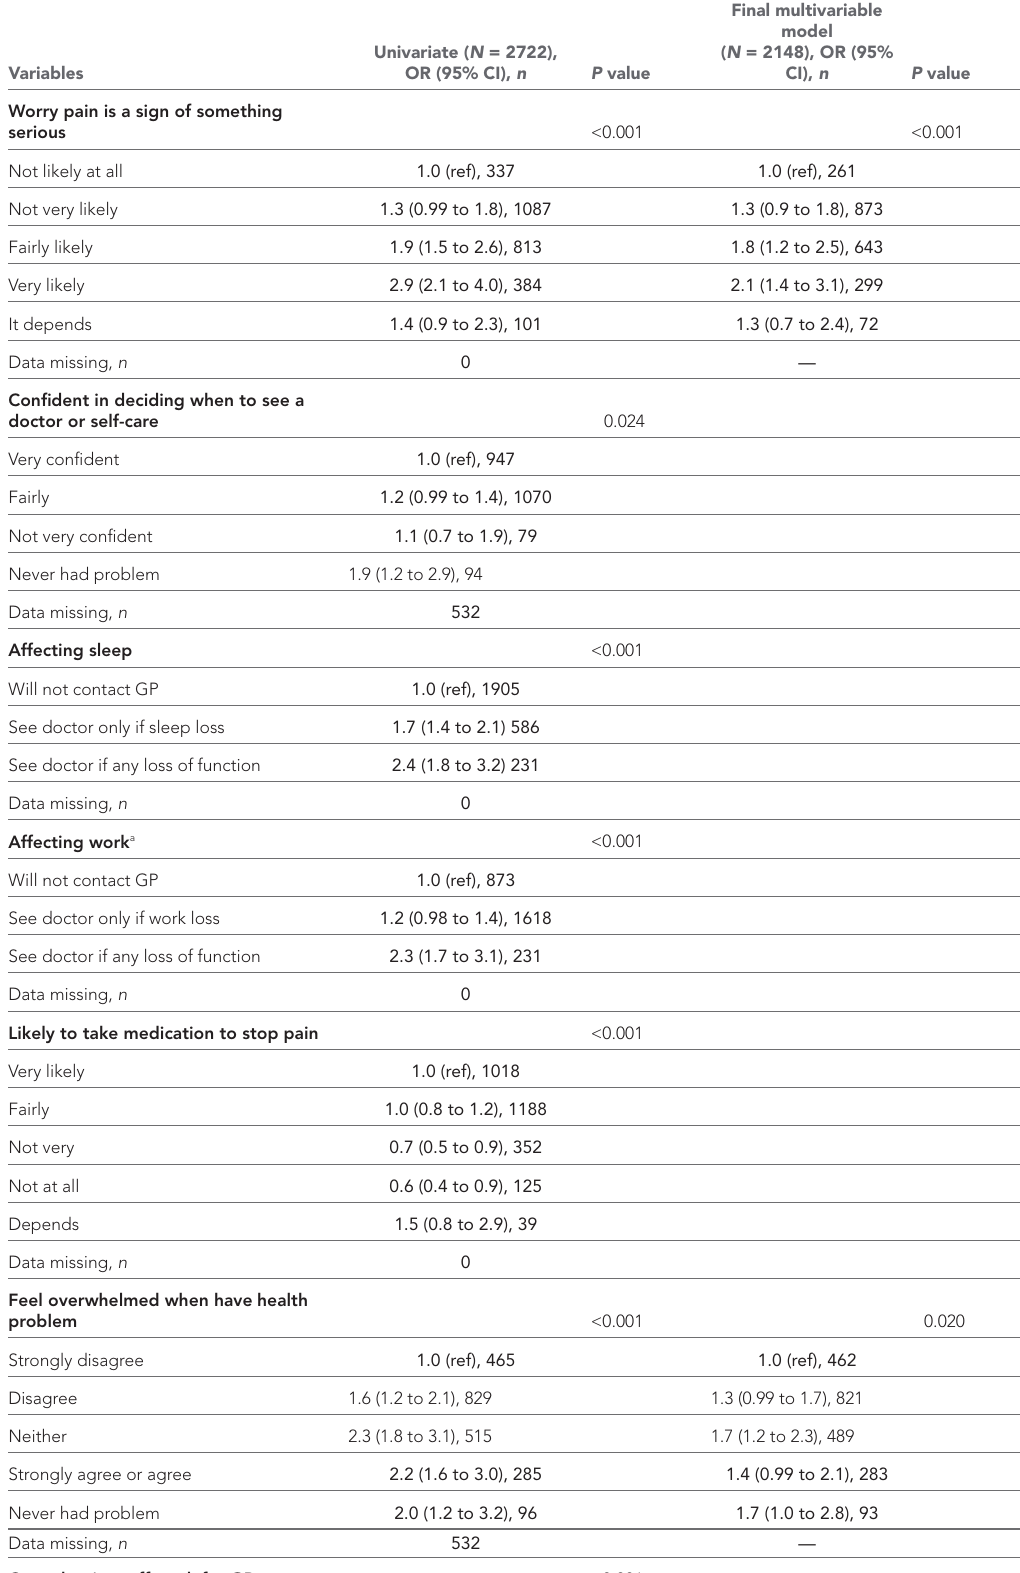
Table 5 Factors measuring programme theories: association with tendency to contact GP rather than self- care for minor